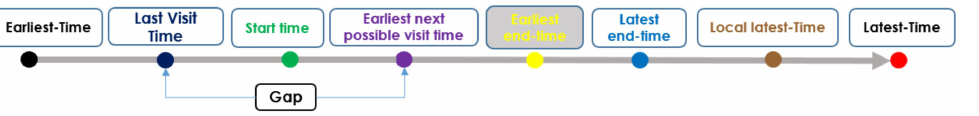
Figure 18. Earliest next visit time: it is located between the start-time and the